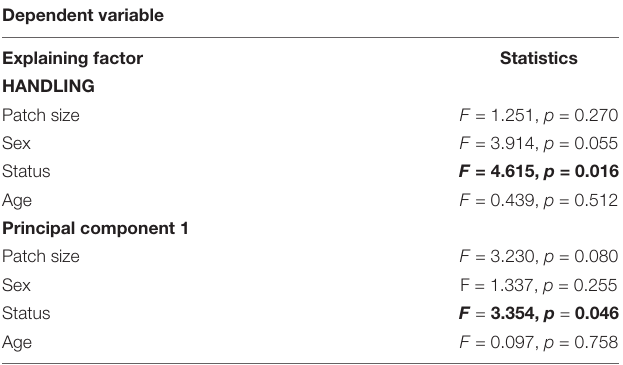
TABLE 4 | Results of the additive linear models for each behavioral measurement and principal component 1.